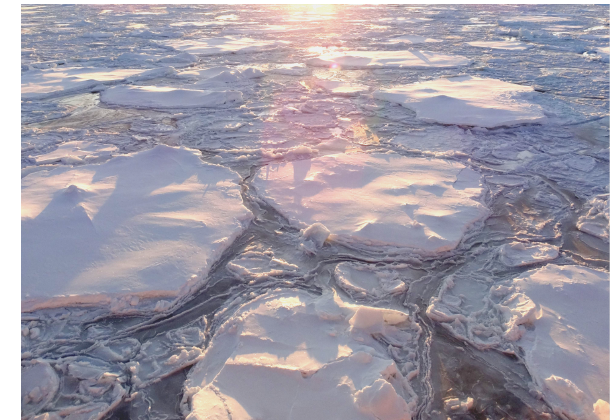
Figure 2. Aggregate of ice floes cemented together by thin ice in the marginal ice zone (Weddell Sea, Antarctica). The size of the largest floes is on the order of 10m. Picture taken on board the RRS James Clark Ross in March 2014. Credit: Heather